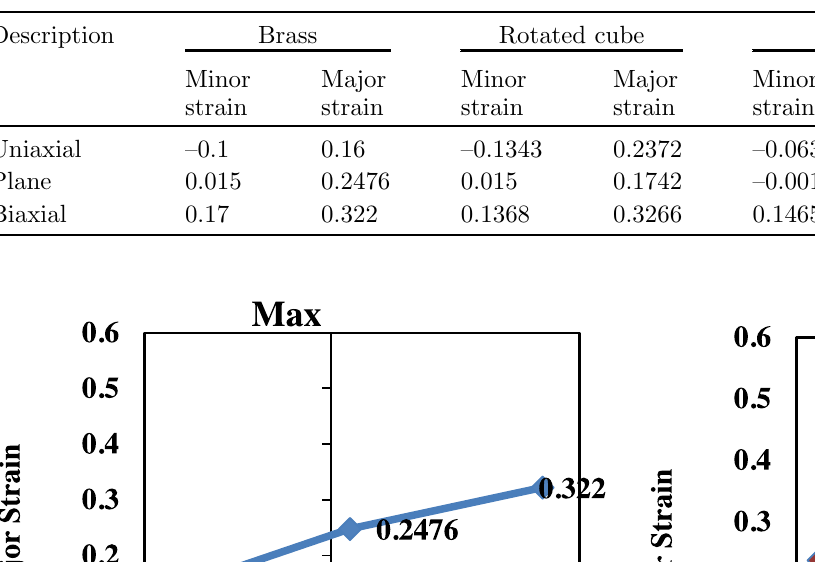
Table 4. Maximum in-plane and minimum in-plane principal strain values from the numerical simulation.